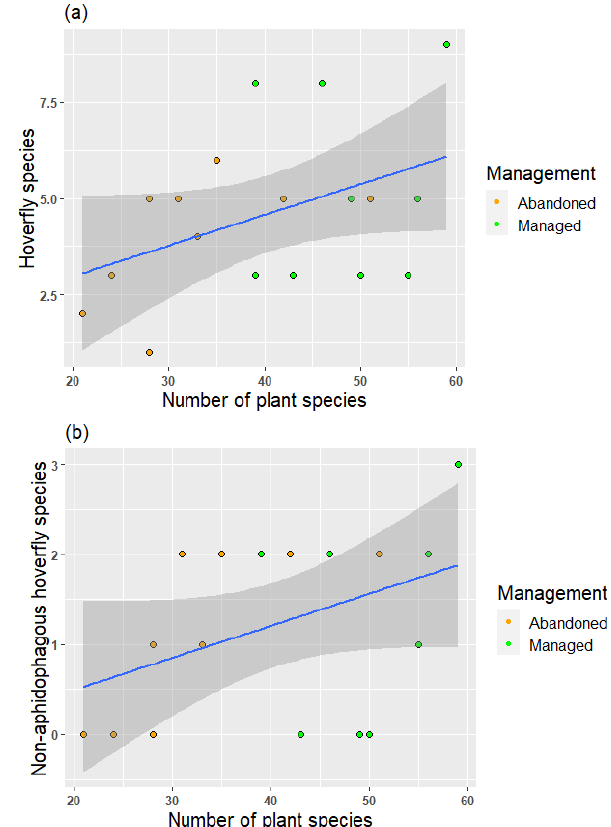
Figure 2. Regression showing (a) the significant relationship be- tween the number of hoverfly species and the number of plant species and (b) the significant relationship between the number of non-aphidophagous species and the number of plant species in man- aged and abandoned meadows with a 95% confidence interval.